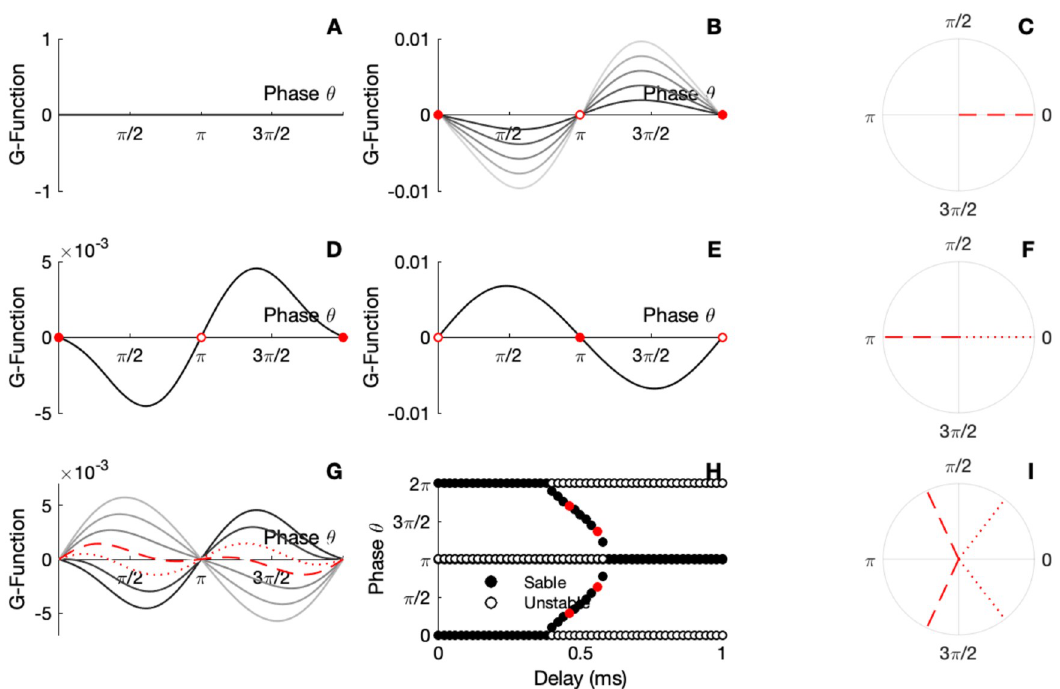
Fig 7. Locking modes of the ING network system. Effect of coupling strength on locking modes without delay. A) The panel gives the G -function for different parameter G = d = 0. The circles are filled for stable fixed point and empty for the unstable points. C) Resulting locking mode when there is no delay. D) The panel gives the G -function for d = 0.1. E) The panel gives the G -function for d = 0.6. The circles are filled for stable fixed point and empty for the unstable points. F) Resulting locking mode for short and large delay. G) The panel gives the G -function for different parameter d . H) Bifurcation analysis. The circles are filled for stable and empty for the unstable fixed points, red dots represent the illustrations parameters I) Resulting locking modes. Parameters: N �